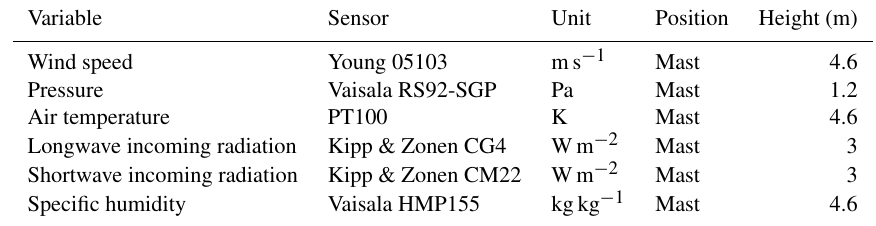
Table 2. Presentation of the forcing data (name, unit, and position on the mast) and instruments used for the measurements. Variable